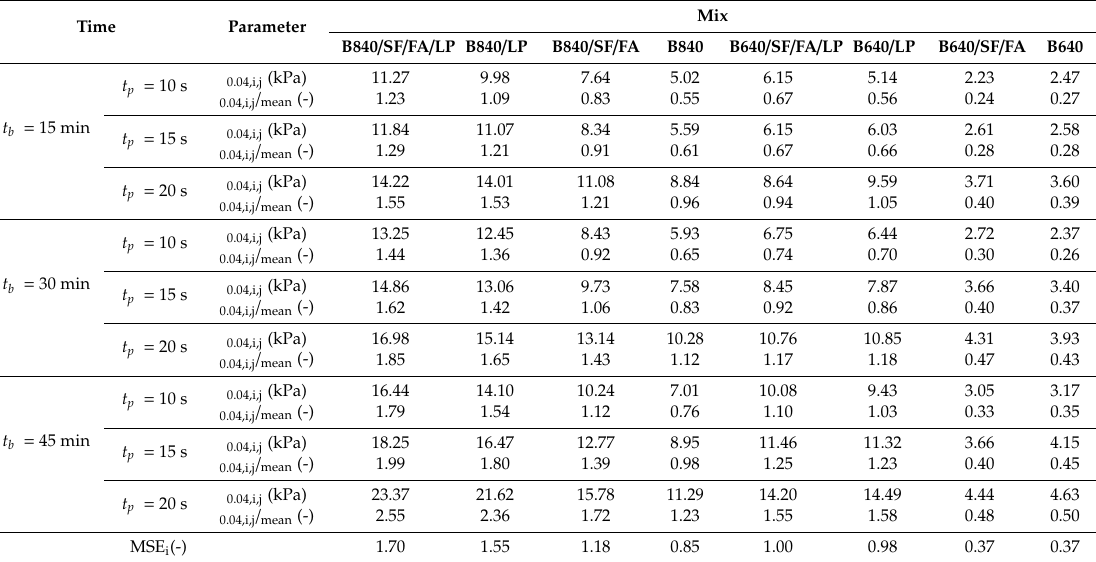
Table 5. Comparison of fresh concrete compressive strength.